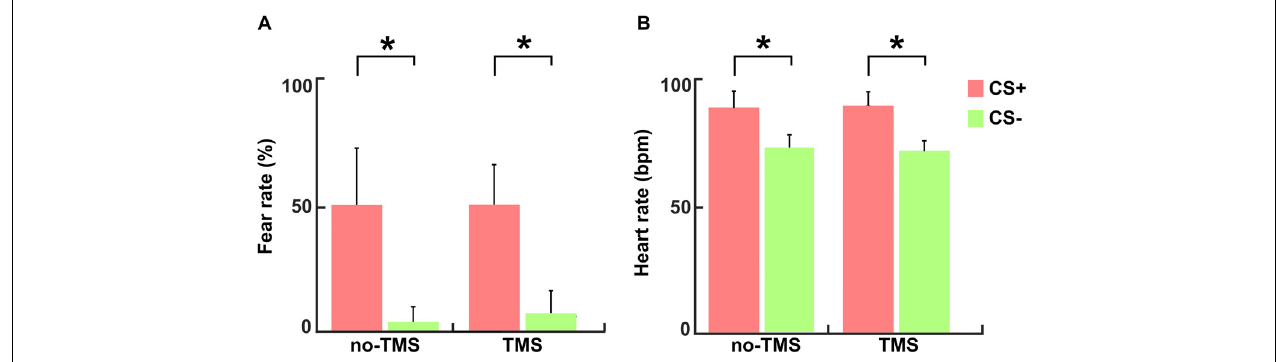
FIGURE 3 | For both experiments (no-TMS and TMS) the (A) subjective fear ratings and (B) heart rates. The light red bar represents CS+ and light green denotes CS–. The values are mean ± standard deviation. The asterisk ( ∗ ) denotes significant differences after correcting for multiple comparisons ( p < 0.001, Bonferroni corrected).